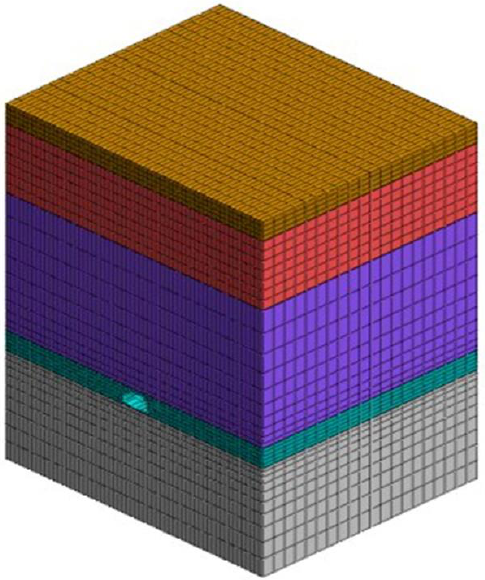
Figure 15. Numerical simulation model.